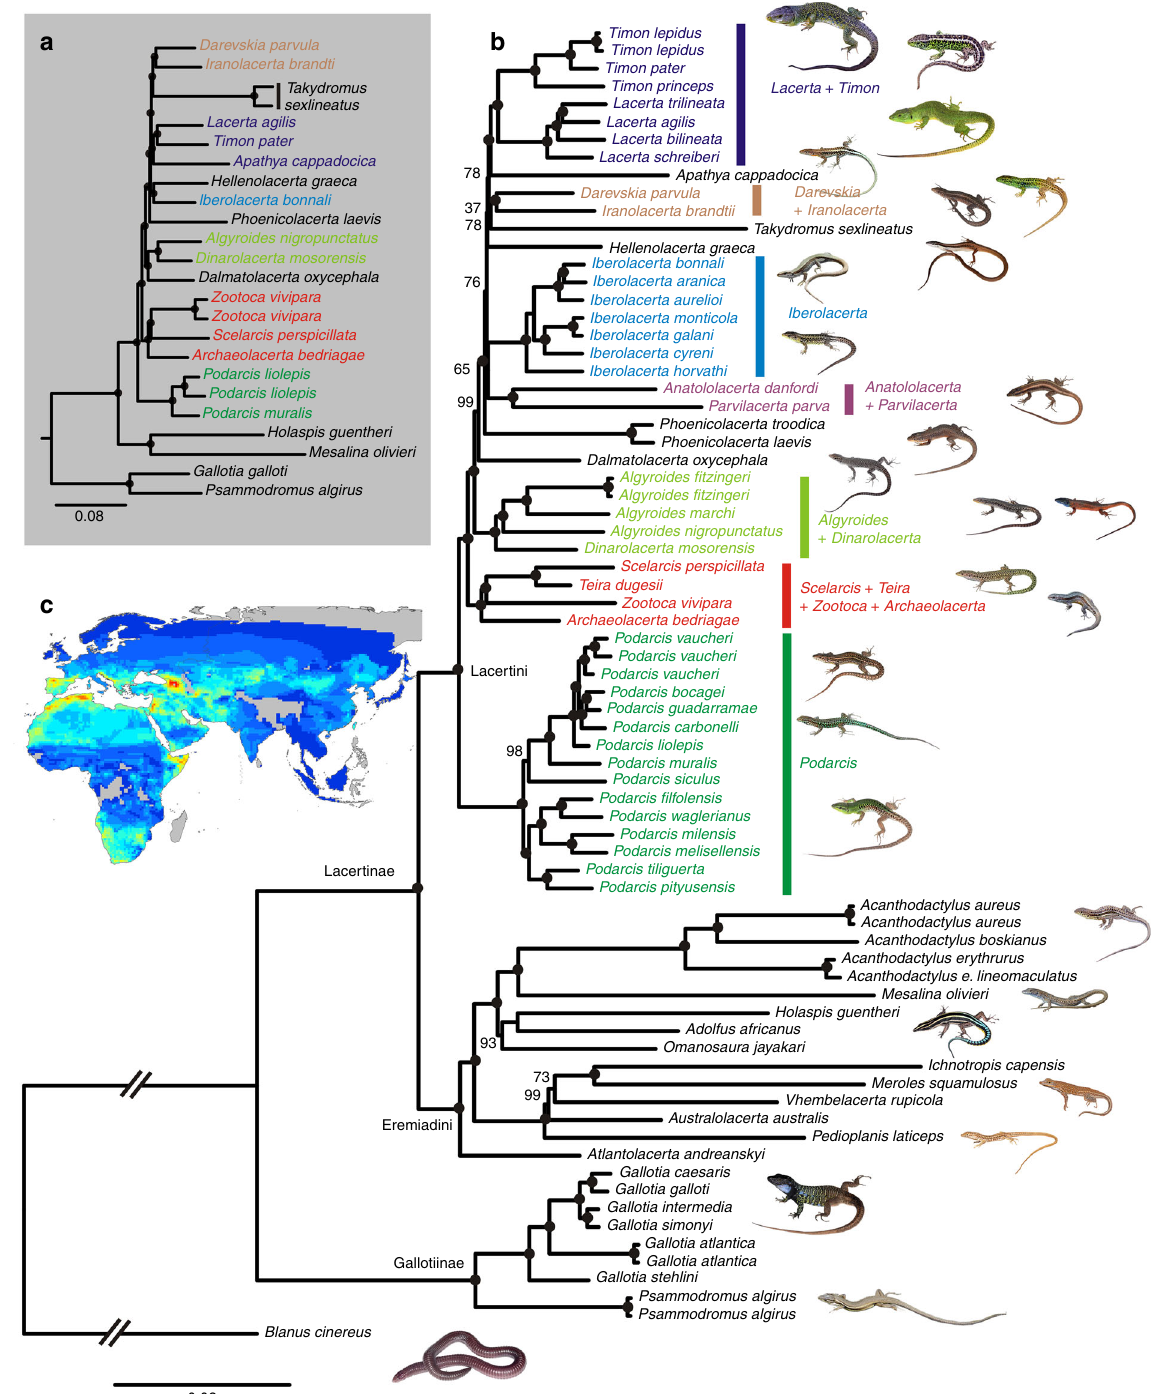
Fig. 1 Phylogenomic reconstruction of lacertid lizard phylogeny. Maximum Likelihood trees are based on a 6269 protein-coding nuclear loci (11,087,328 nucleotide positions) obtained by RNAseq and b 324 anonymous nuclear loci (558,418 nt) from anchored hybrid enrichment sequencing. Black dots indicate 100% support from ultrafast bootstrap with lower values provided at relevant nodes. Main clades recovered within Lacertini are indicated with colored bars. c Species richness of lacertid species compiled from the Global Assessment of Reptile Distributions 9 ; warmer colors represent higher protein-coding nuclear loci for 21 lacertid species obtained by analyses, performed separately on each dataset, recovered largely adding novel RNA sequencing (RNAseq) data to a previously congruent tree topologies (Fig. 1, Supplementary Fig. 2S). All established set of vertebrate loci 29 , and (ii) 324 anonymous nodes in the RNAseq-ML tree received full bootstrap support, nuclear loci for 65 species obtained by anchored hybrid enrich- and the same was true for most nodes in the AHE-ML tree. Gene ment sequencing (AHE) 30 . Importantly, partitioned maximum jackkni fi ng proportions (GJP) 29,31 , which provide a more strin- likelihood (ML) concatenation and coalescent species tree gent test for monophyly than non-parametric bootstrapping,